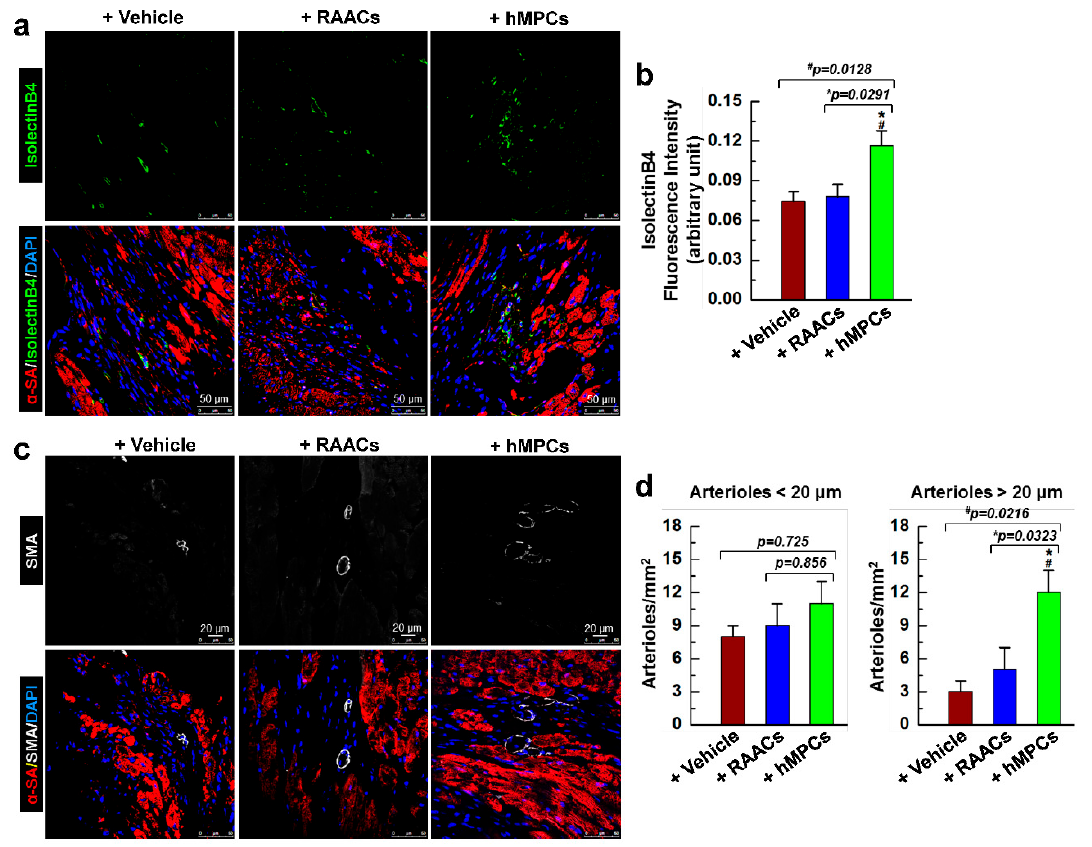
Figure 7. Transplantation of hMPCs enhances the endogenous cardiac vascular regeneration. ( a ) Representative immunohistochemistry images for the staining of endothelial cell maker isolectin B4 (IB4) in the risk area of infarcted mouse hearts. Green color indicates IB4-positive cells, red color indicates α -SA-positive cells, and blue indicates DAPI-stained nuclei. ( b ) Quantitative analysis for the fluorescent intensity of IB4 in different groups of heart section staining. ( c ) Representative confocal images for the staining of SMA in the risk area of infarcted heart sections. Green color indicates SMA-positive cells, red color indicates α -SA-positive cells, and blue color indicates DAPI-stained nuclei. ( d ) Quantitative analysis for SMA positive arterioles smaller or larger than 20 µm in diameter. The y-axis represents the number of arterioles per mm 2 . Note: n = 6 mice per group, 20 images/slide. Data are means ± SEM. * p < 0.05 versus Vehicle group, # p < 0.05 versus RAAC group, which were calculated by one-way ANOVA followed by Tukey’s multiple comparison test.